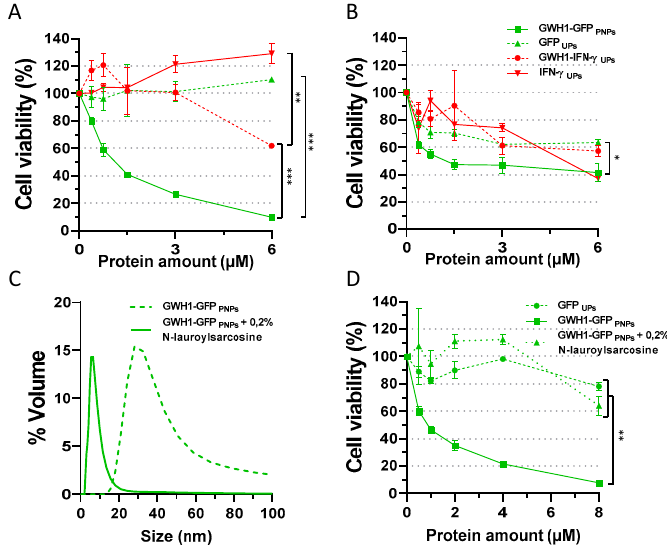
Figure 2. Antimicrobial activity of assembled (PNPs) and unassembled soluble proteins (UPs) in vitro. ( A ) Effect on cell viability of increasing amounts of GWH1-GFP and GWH1-IFN- γ against E. coli and ( B ) S. aureus ( C ). Dynamic light scattering (DLS) analysis showing the nanoparticle disassembling of GWH1-GFP in presence of 0.2% N-lauroylsarcosine. ( D ) Comparative e ff ect on cell viability of disassembled (promoted in presence of 0.2% N-lauroylsarcosine) and assembled GWH1-GFP against